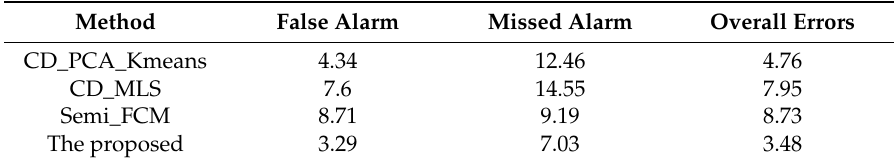
Figure 12. First dataset: CDMs obtained by: ( a ) CD_PCA_Kmeans [1]; ( b ) CD_MLS [2]; ( c ) Semi_FCM method [3]; and ( d ) the proposed framework. Table 1. Change Detection Quantitative Evaluation (%) on the First Dataset (more details can be tracked in Table